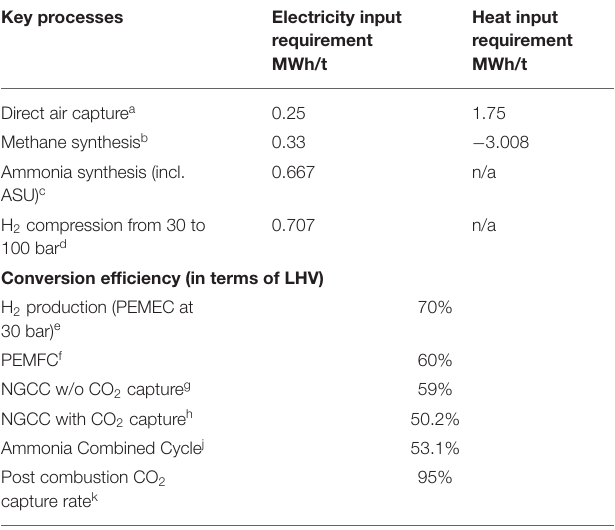
TABLE 2 | Main technology performance assumptions used in this